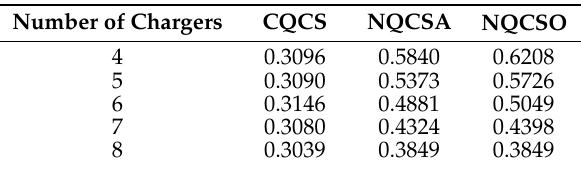
Table 4. Average stay time of charged EVs for CS with different number of chargers in different charging situations (unit: min).